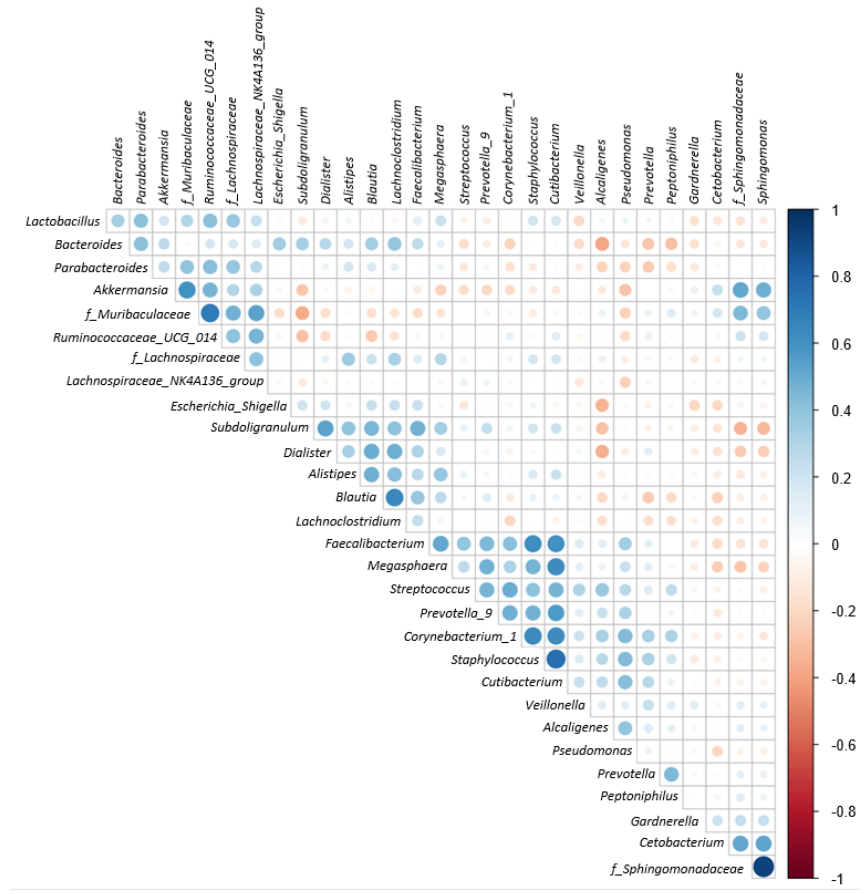
Figure 9. Spearman correlation coefficient plot for exploring dependency between genera. Those categories starting with “f_” means that its “family” taxonomic information is recorded instead of genus. Different color shade of right side color bar represents Spearman correlation coefficient. Blue means positive correlation; red means negative correlation.